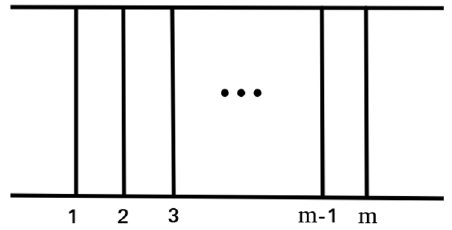
Figure 1. S-channel ladder with the exchange of m t-channel gravi-reggeons (gravitons).